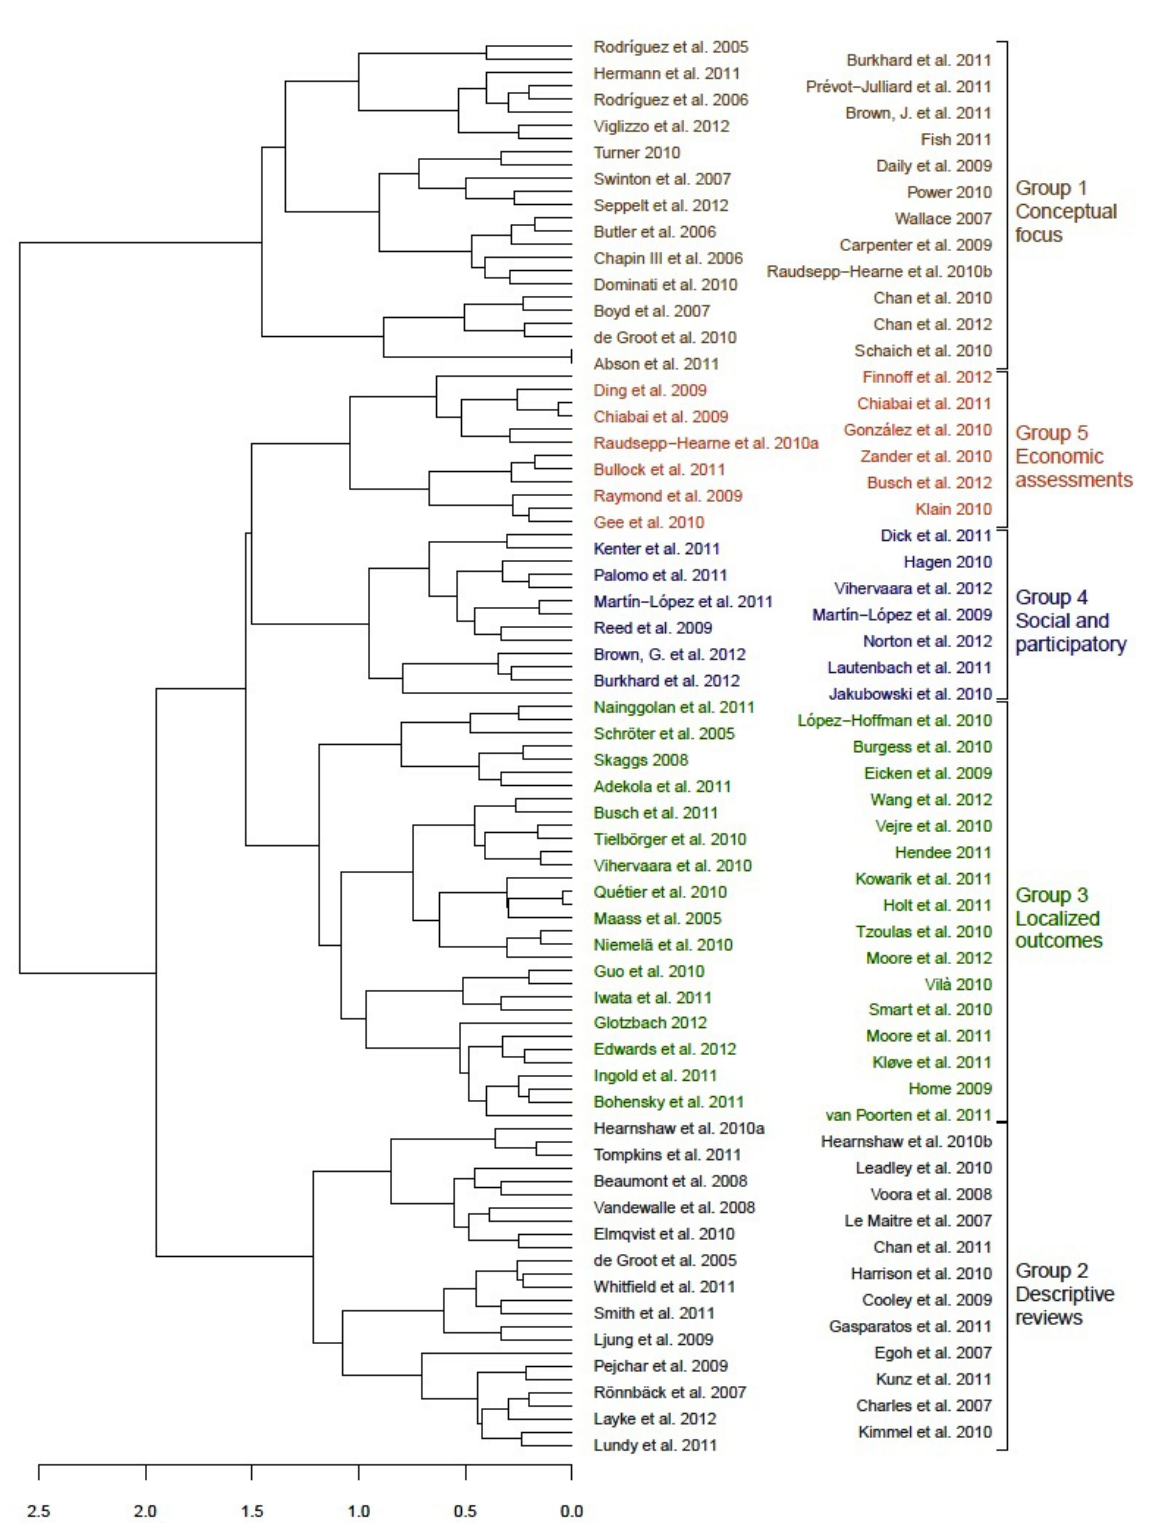
Fig. 6 . Dendrogram showing the five groups of publications identified by the cluster